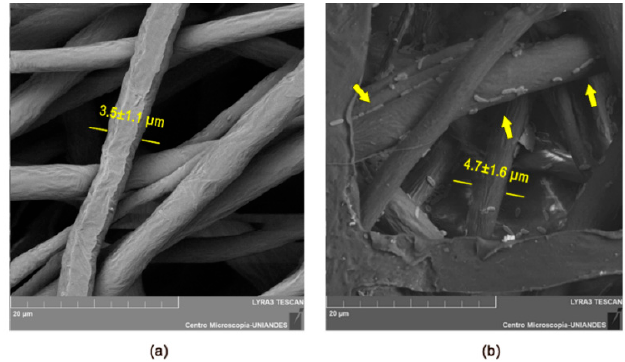
Figure 2. ( a ) Scanning electron microscopy (SEM) micrograph of a PCL membrane freshly synthesized (average diameter is 3.5 ± 1.1 µm). ( b ) SEM micrograph of a PCL membrane with immobilized bacteria (average diameter is 4.72 ± 1.64 µm).